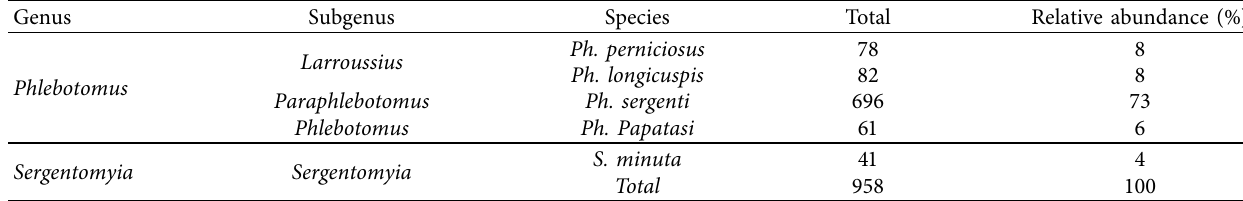
Table 2: Number and relative abundance of species.